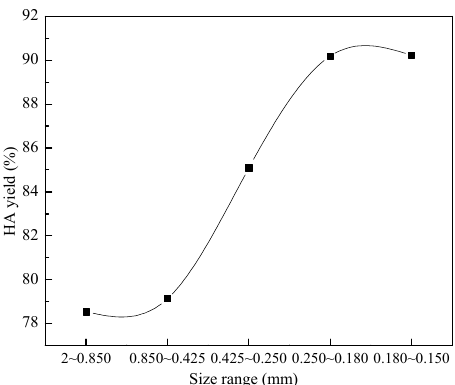
Figure 6. Effect of coal size on the HA yield.